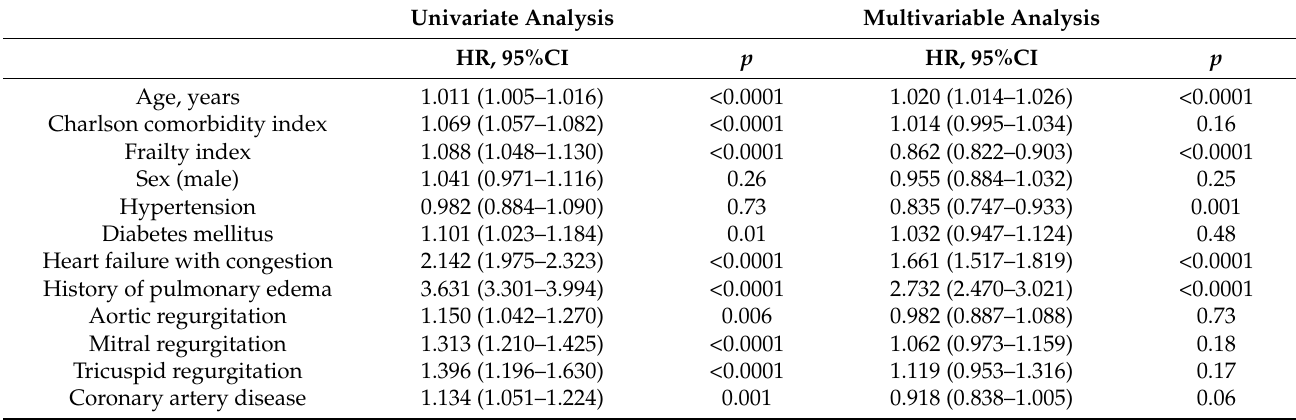
Table 3. Predictors of cardiovascular mortality in patients treated with